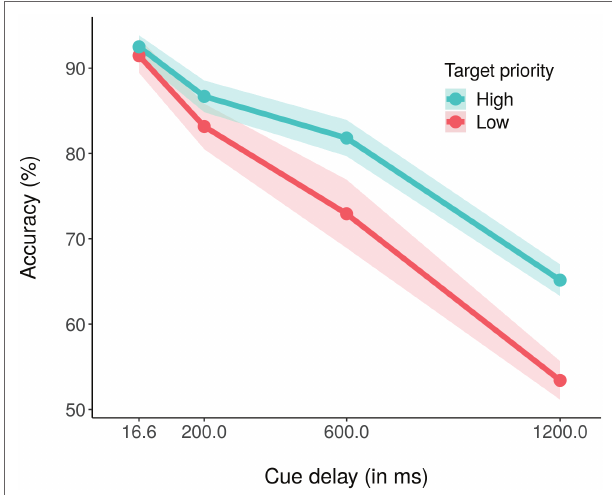
FIGURE 2 | Mean percentage accuracy in the high (blue coded) and the low (red coded) priority conditions for the four cue delays. The shaded area around each line stands for the standard error of the